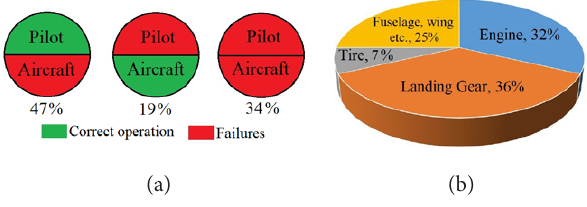
Figure 1. Aviation problems risk scorecard: (a) – scorecard of situations what lead to aviation accidents; (b) – distribution